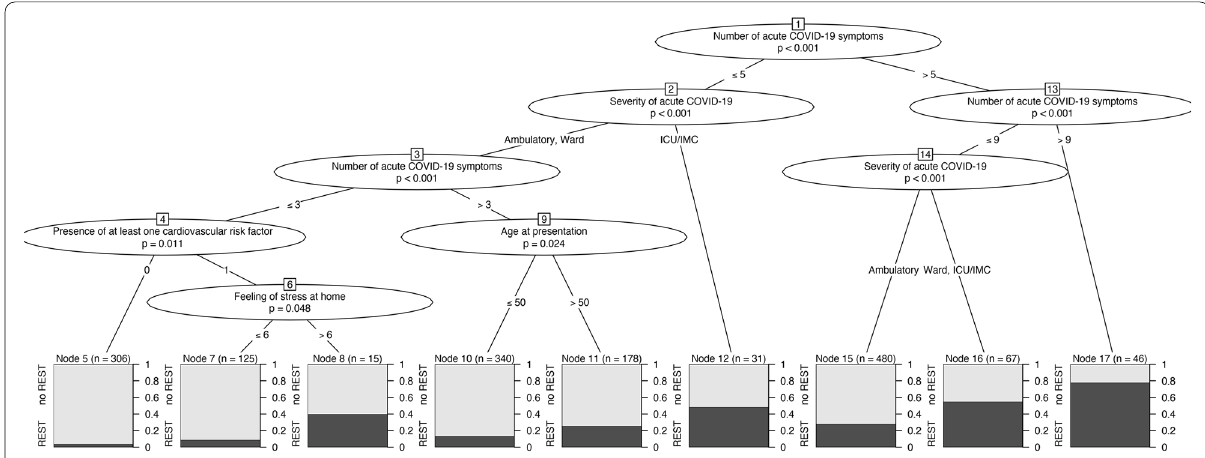
Fig. 1 Results of the the model‑based recursive partitioning (MBRP)